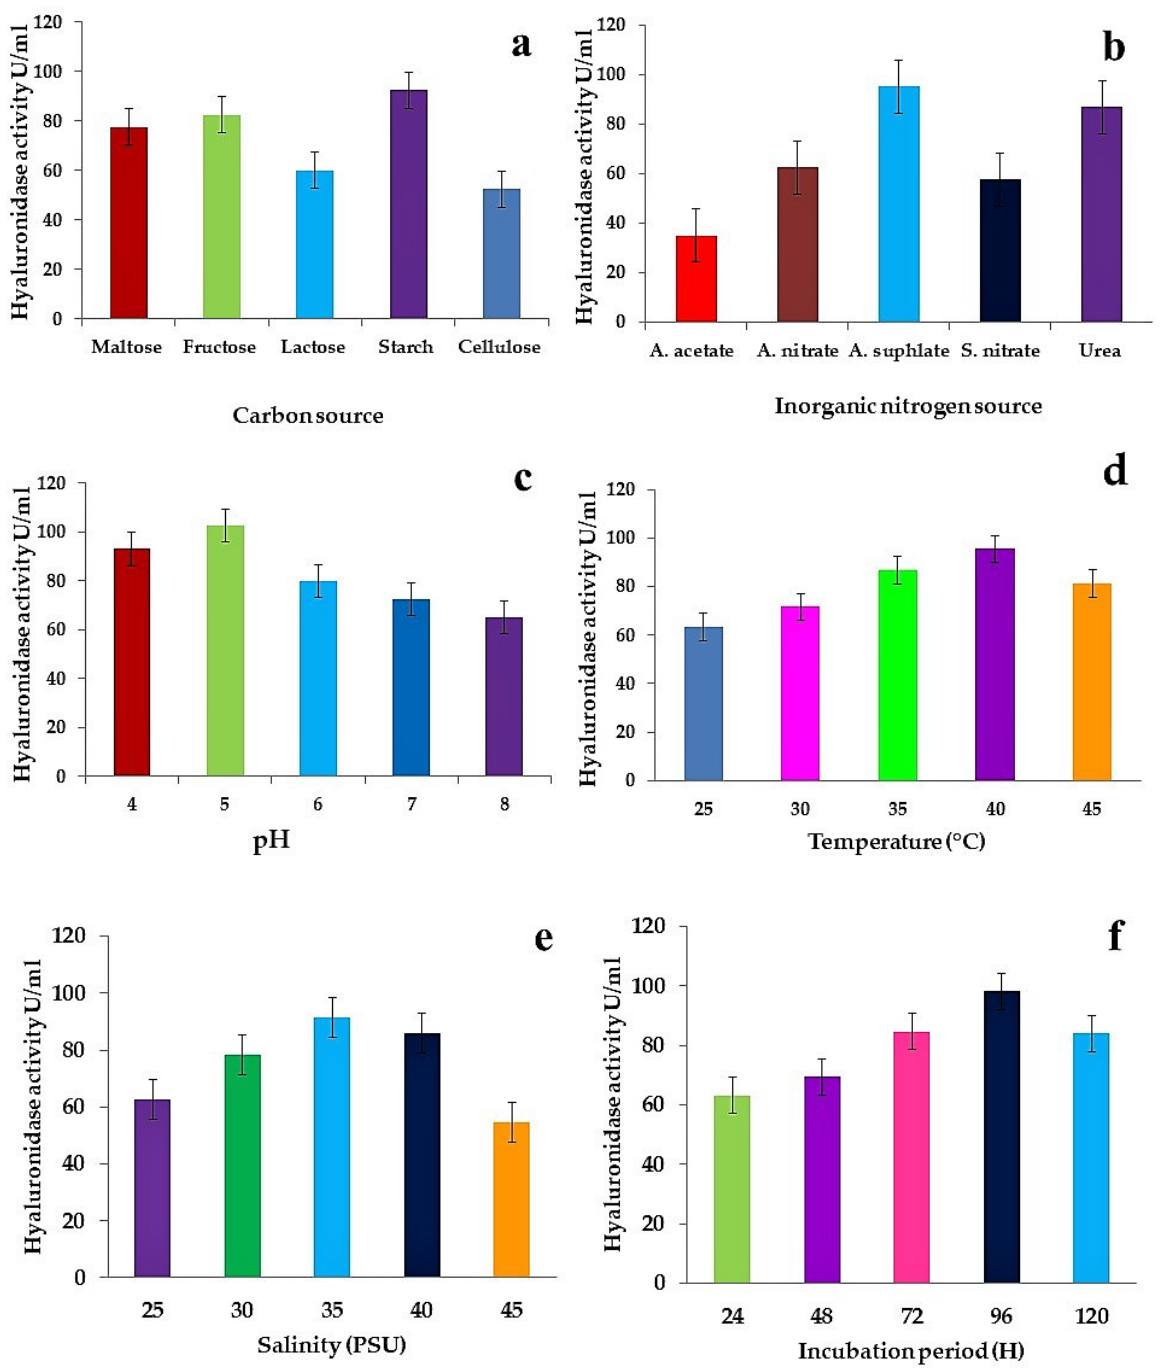
Figure 5. Optimization of hyaluronidase enzyme production from marine S. aureus CASMTK1. The optimization and production of hyaluronidase were done under nutritional factors and physical